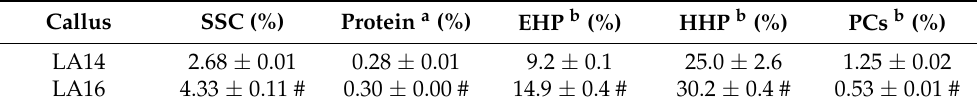
Table 1. The composition of callus of narrow ‐ leaved lupin L. angustifolius .